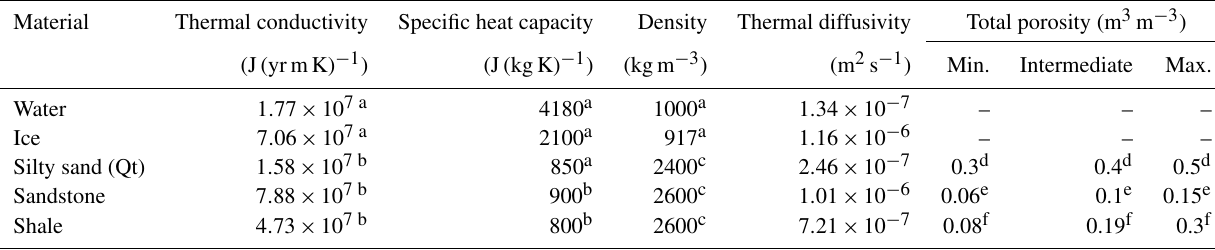
Figure 5. (a) Three-dimensional geological model of the subsurface below the valley floor in Adventdalen and vertical one-dimensional simplifications (inset in upper right corner) below zones of the model area. The former determines the hydrogeological properties in the groundwater model (Table 3), whereas the latter determines the geothermal properties in the 1DHT model (Table 2). The domain of the 1DHT model extends to 1000mb.g.l. (not shown). Deeper than 300mb.g.l., geothermal properties were defined like those for the Janusfjellet Subgroup. The sea retreat reconstruction was inferred from absolute datings (Table 1) and is illustrated by valley floor exposure isochrones (dashed red lines). Pingos are indicated with blue arrows. (b) Vertical view of the model area showing the zonation. The aforementioned isochrones defined the zone names so that the valley floor exposure age of a zone is apparent from its name (i.e. zone 0–1 became sub-aerially exposed between 1 and 0ka, zone 1–2 between 2 and 1ka, etc.). Table 2. Geothermal material properties used in the heat transfer